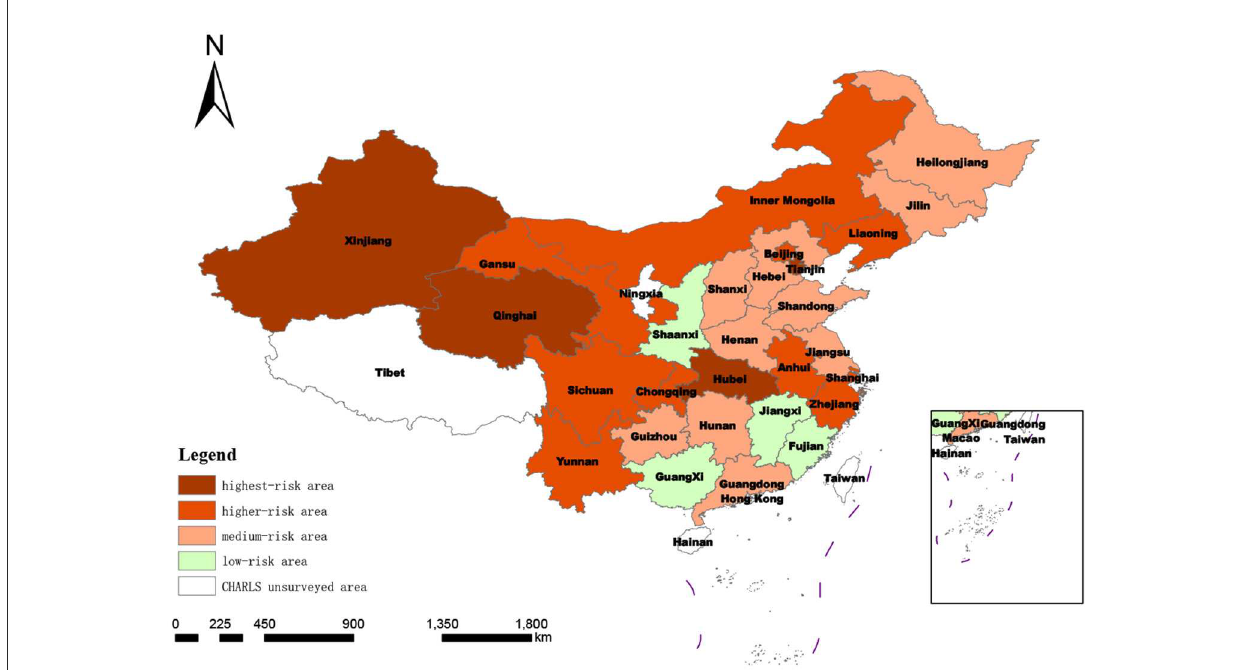
FIGURE6 Spatial distribution of degree of regional social disability risk based on micro-system